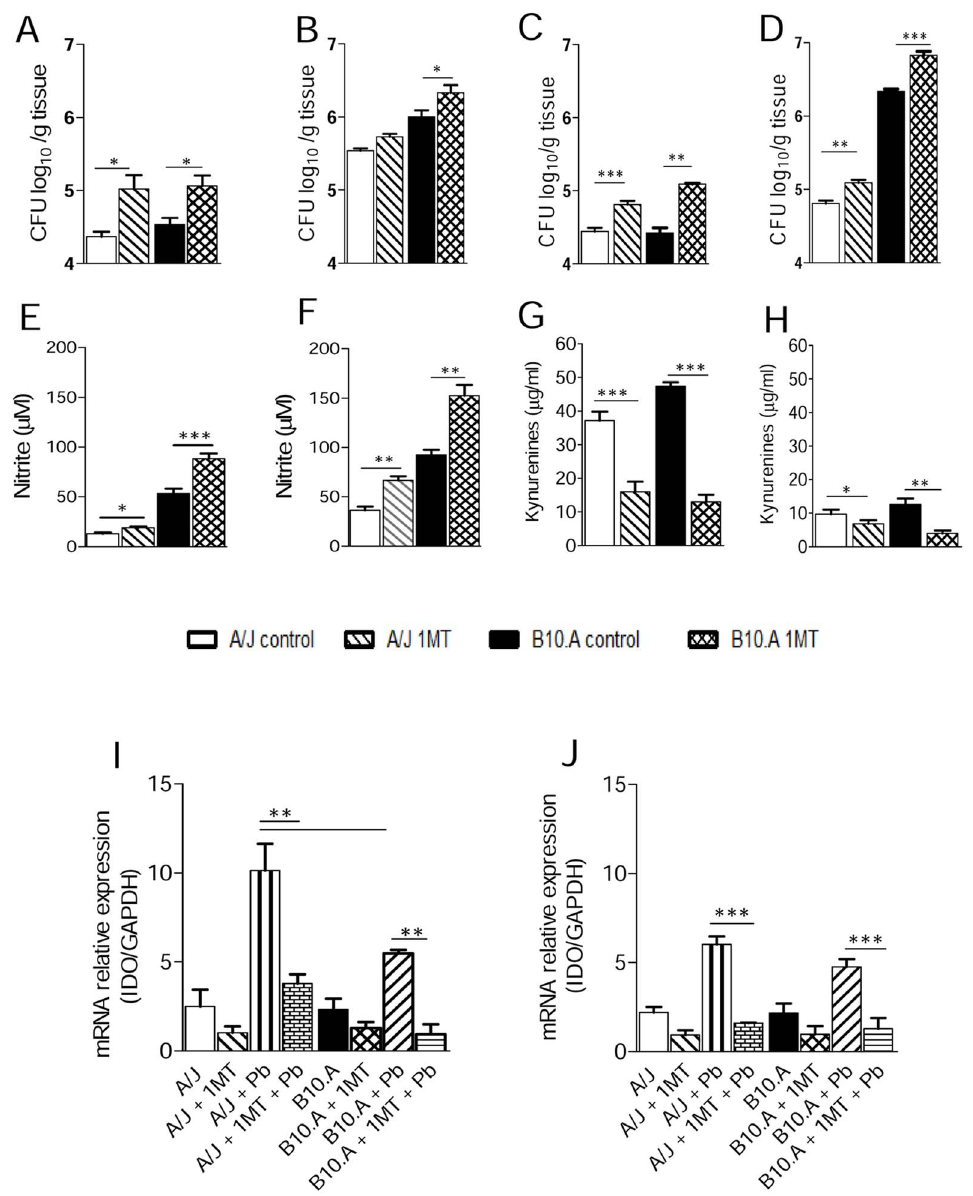
Figure 3. In pulmonary paracoccidioidomycosis, 1MT treatment increases fungal loads and pulmonary NO but reduces kynurenines levels and IDO mRNA production. ( A, B ) Determination of fungal loads by CFU assays in the lungs of A/J and B10.A mice (n=5–6), treated or not with 1MT, at weeks 2 and 8 after infection with 1 6 10 6 yeasts. ( C, D ) Groups (n=6–8) of B10.A and A/J mice received subcutaneous implants of 1MT releasing or control pellets (5 mg/ml/day) and disease severity assessed by CFU assays at weeks 4 and 8 after infection with 1 6 10 6 yeast cells of P. brasiliensis . The bars depict means 6 SEM of log10 CFU. The results are representative of 2 experiments with equivalent results (** p , 0.01, and *** p , 0.001). Levels of ( E, F ) nitric oxide and ( G, H ) kynurenines were measured in lung homogenates. NO production was measured by Griess reagent, and kynurenines were evaluated using Ehrlich’s reagent. ( I, J ) IDO mRNA was measured using TaqMan real-time PCR assay. Data are means 6 SEM of three independent experiments at weeks 2 and 8 after infection with similar results (* p , 0.05, ** p , 0.01 and *** p ,